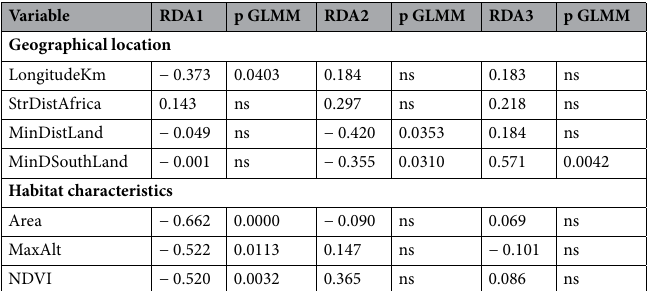
Table 5. Correlation of island variables with significant RDA axis. The p values are obtained from univariate mixed models with island identity as a random effect. ns: